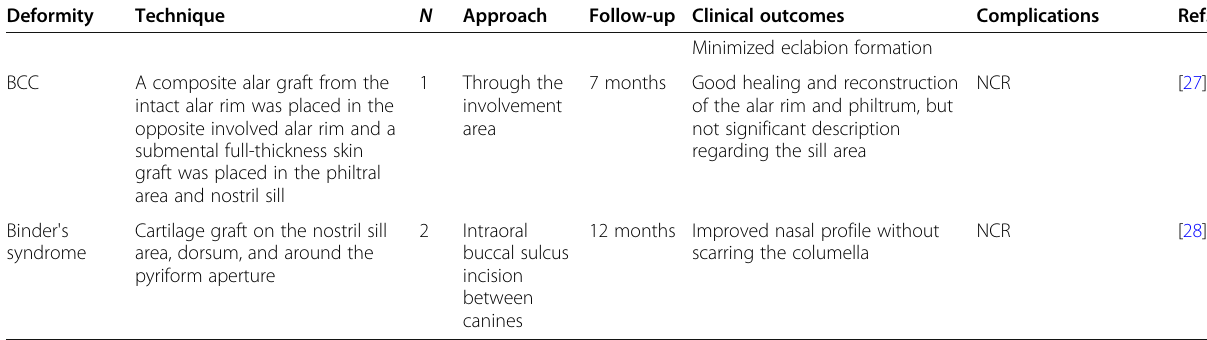
Table 2 The data of articles addressing the sill graft/augmentation in terms of the technique, approaches, clinical results, and complications. UCL , unilateral cleft lip; BCC , basal cell carcinoma; AB , alar base; NCR , no complications reported (Continued)